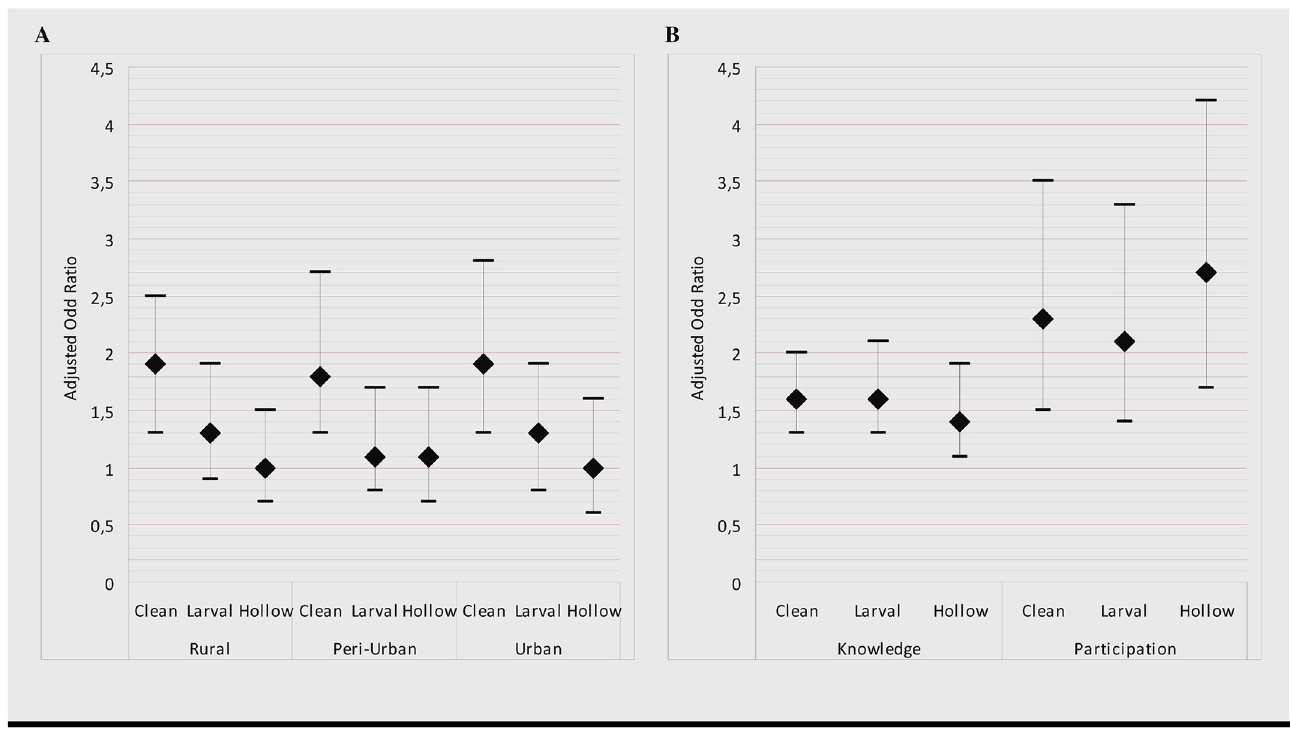
Fig 2. Relationship between larval control practices and household location, mothers ’ knowledge and participation in malaria information sessions. A: Reference = rural highly exposed to malaria. A and B: Clean = cleaning of the house and its surroundings; Larval = eradication of larval sites; Hollow = elimination of hollow objects able to contain water. All models are adjusted for household size, ownership of cattle and/or agricultural land, access to potable water and/or to private toilets. B: Knowledge = mothers ’ knowledge about malaria; Participation = participation in information session.